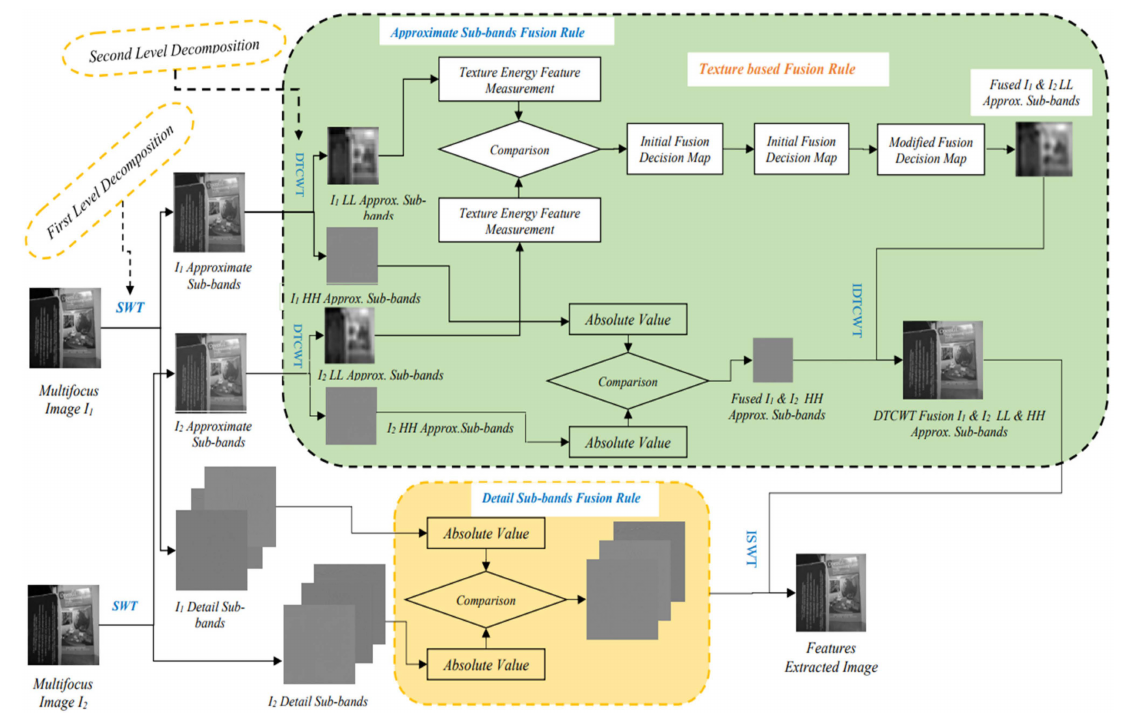
Figure 1. Hypothesized SWT and D-TCWT with TEM -based image